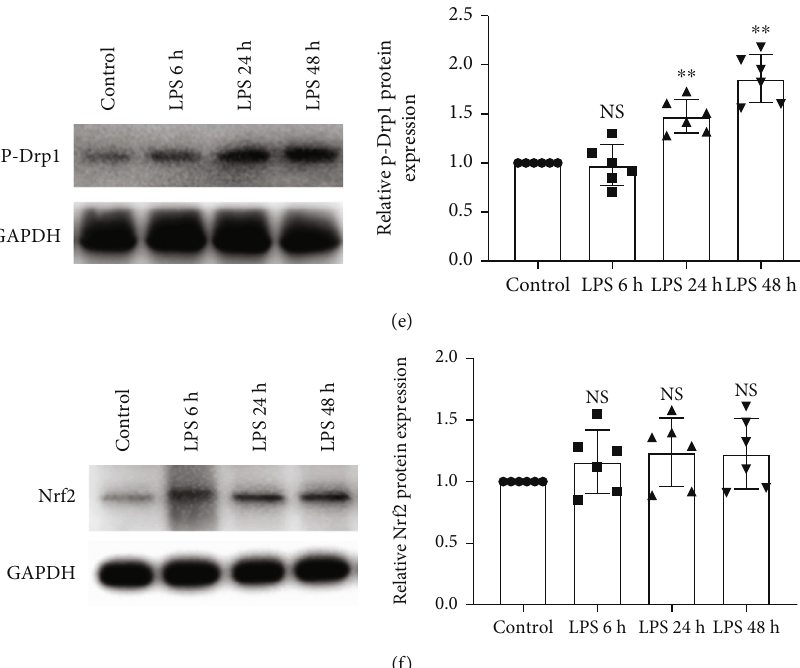
Figure 2: Sepsis-subjected AECII apoptosis was closely positive with mitochondrial dysfunction. (a) The mice were subjected to CLP surgery for 24 and 48 hours. Primary AECIIs were isolated with fl ow cytometry and stained with Annexin V and 7-AAD. The percentage of double Annexin V- and 7-AAD-positive cells after 48 hours of CLP was almost 16%. (b) The AECIIs (MLE-12 cells) were exposed to LPS (25 μ g/ml) for 6, 24, and 48 hours. The percentage of double Annexin V- and 7-AAD-positive cells was detected by fl ow cytometry. (c) The expression of mitochondrial biogenesis-related proteins (PGC-1 α , Tfam, and Nrf1) was detected with western blotting. (d) The mitochondrial ATP content was detected by an ATP fl uorometric assay kit. (e, f) Mitochondrial fi ssion protein p-Drp1 and antioxidant Nrf2 protein expressions were detected using western blotting. Data are represented as mean ± SD , n = 6 per group. NS: nonsigni fi cance; ∗∗ P < 0 : 01 or ∗∗∗ P < 0 : 001 vs. the control